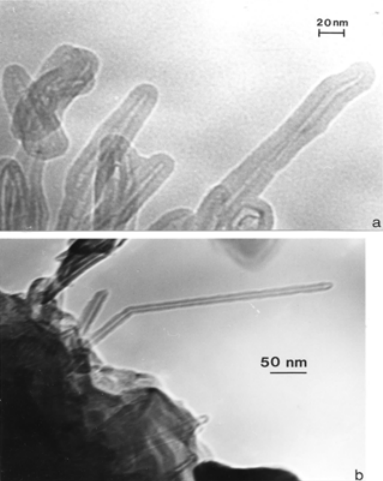
Figure 13: TEM images for environmental MWCNTs. (a) MWCNTs collected near a natural gas electric power generation plant. (b) MWCNTs and aggregated graphitic PM in wood soot. (From Murr and Guerrero [50]).